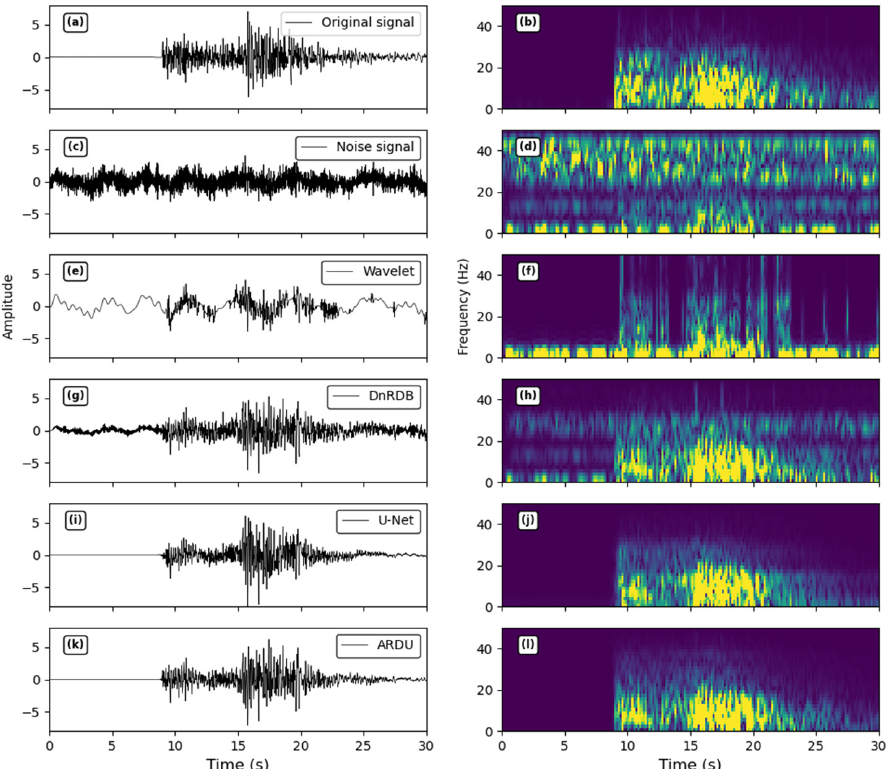
Figure 13. Denoising results of seismic signals with an SNR of 0 dB using different methods.